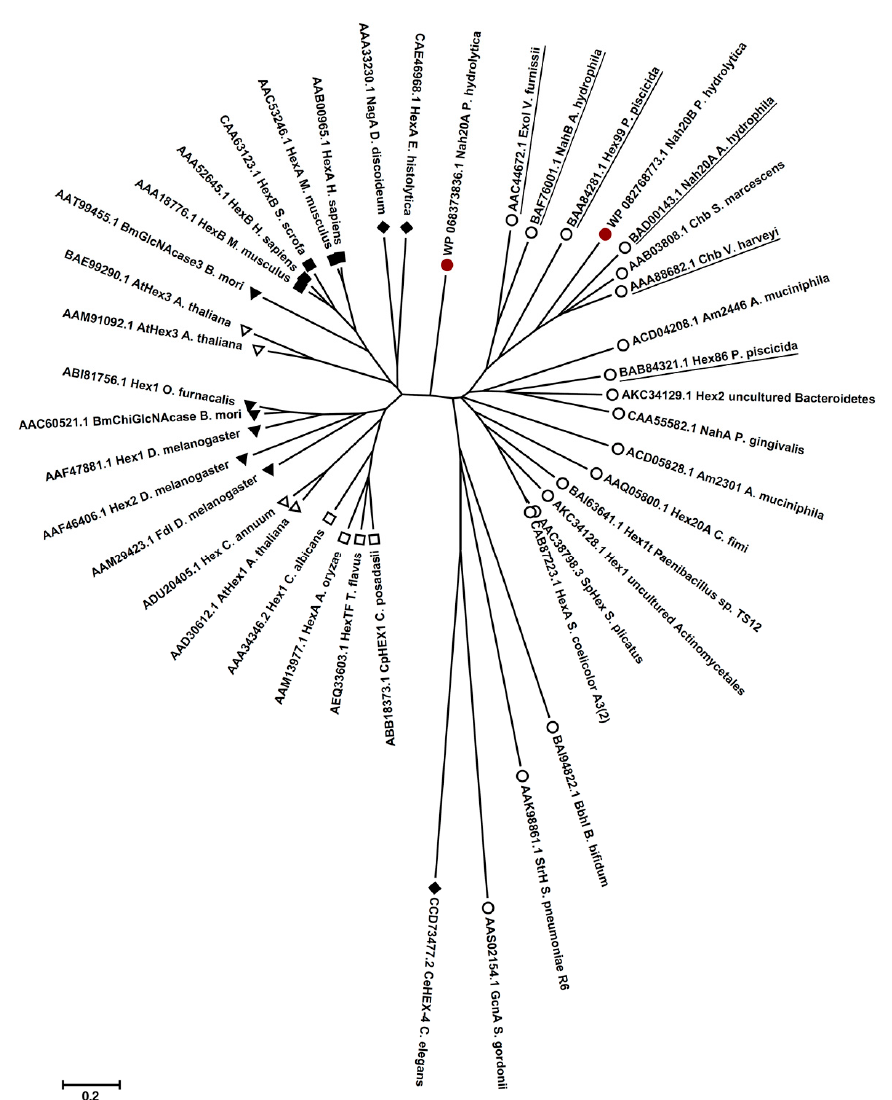
Figure 2. Schematic phylogenetic tree of Ph Nah20A, Ph Nah20B (both marked with red circles) and 41 biochemically characterized GH20 (EC 3.2.1.52) enzymes. Evolutionary analyzes were conducted, and the tree was composed and visualized using MEGA v 7.0.26 [55]. Protein sequences were aligned with Clustal Omega and the BLOSUM62 protein weight matrix was used. Evolutionary relationships were calculated using the Neighbor-Joining method. Evolutionary distances were computed using the Poisson correction method. All positions containing gaps and missing data were eliminated, and there was in total 292 positions in the final dataset. The tree is in scale with branch lengths in the same units as those of the evolutionary distances used to infer the phylogenetic tree. Bacterial ( ○ ), fungal ( □ ), plant ( Δ ), insect ( ▲ ) and mammal ( ∎ ) sequences. Amoebae and C. elegans sequences are marked with a filled diamond ( ♦ ). Characterized GH20 enzymes from marine organisms are underlined.